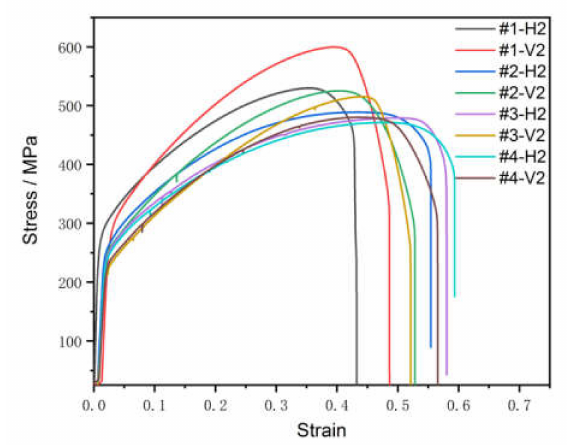
Figure 11. Stress strain curves of the H2 and V2 tensile specimens.